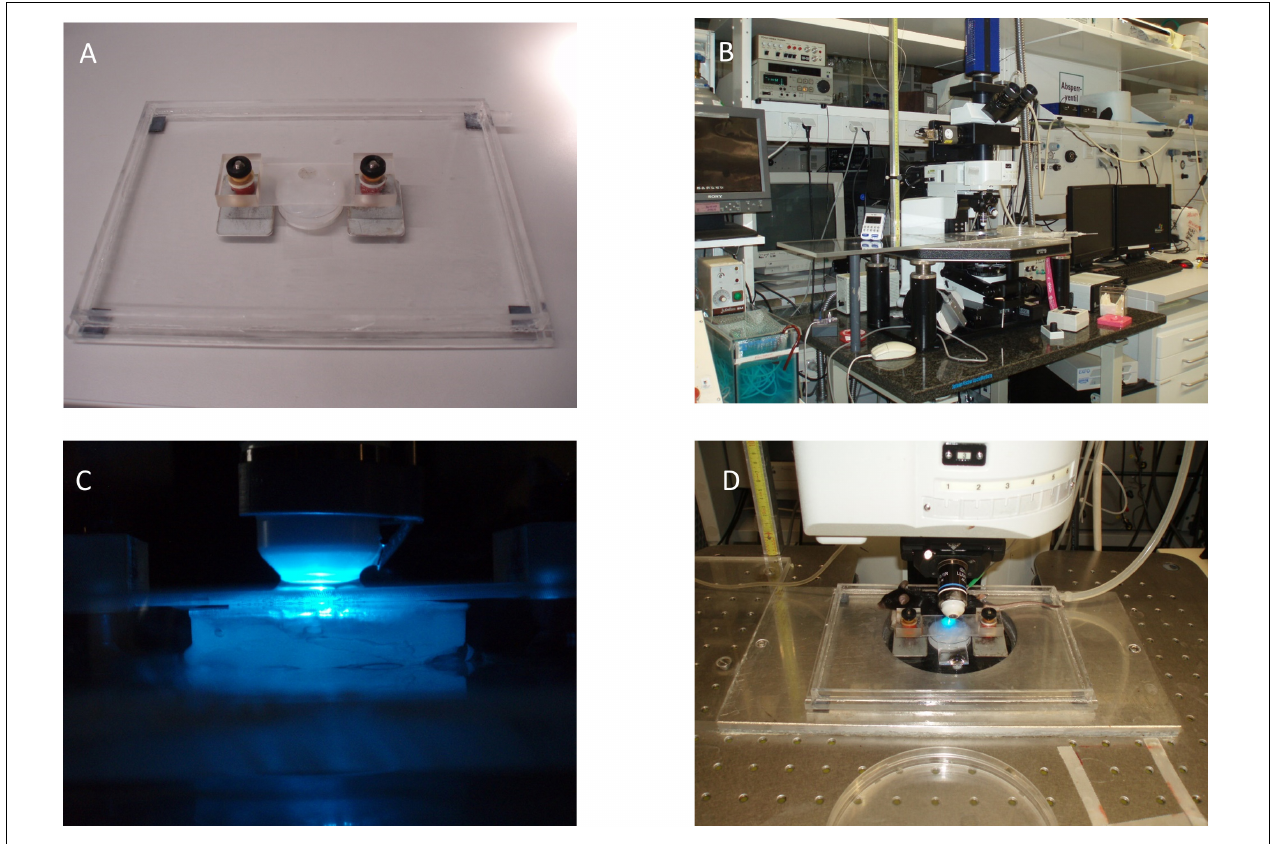
FIGURE 4 | Exemplary fixation and microscope setup. (A) Microscope stage with magnetic spring-counter-weighed holding device. (B) In vivo microscopy setup including water bath and roller pump (lower left of the image). (C) Epifluorescence setup with superfusion-buffer needle attached to the objective. (D) Placement of the fetus and mother animal for